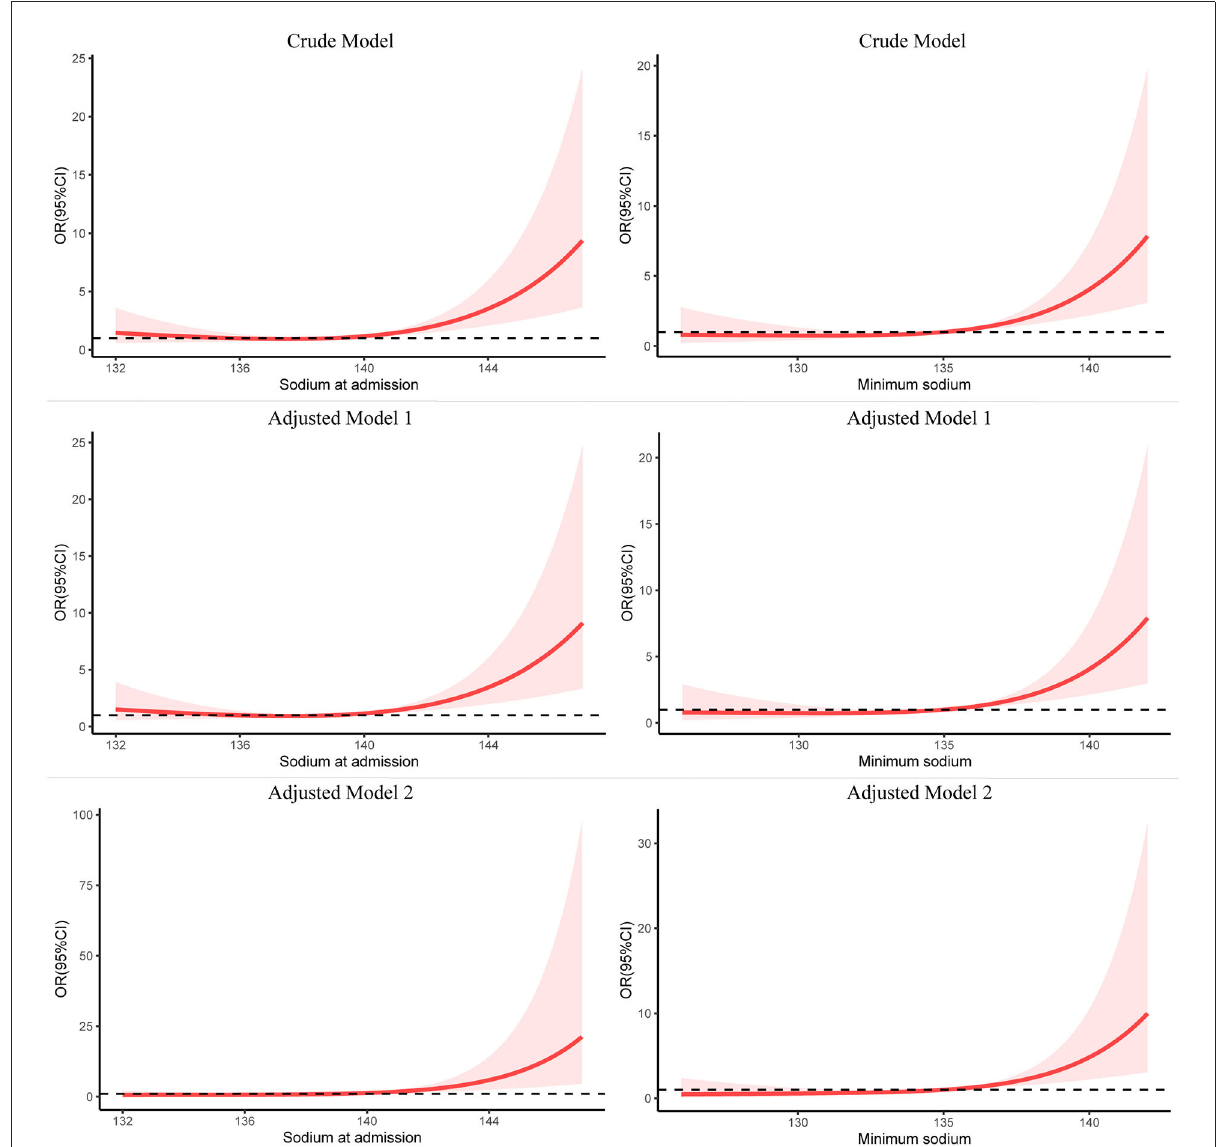
FIGURE2 Restricted cubic spline modeling of the relationship between serum sodium and in-hospital mortality in patients with spontaneous SAH. The adjusted model 1 was for sex and age; the adjusted model 2 was for sex, age, Charlson comorbidity index, GCS, SAPS II, white blood cell count, hemoglobin, platelet count, creatinine, K, and Cl. SAH, subarachnoid hemorrhage; RCS, restricted cubic spline; OR, odds ratio.